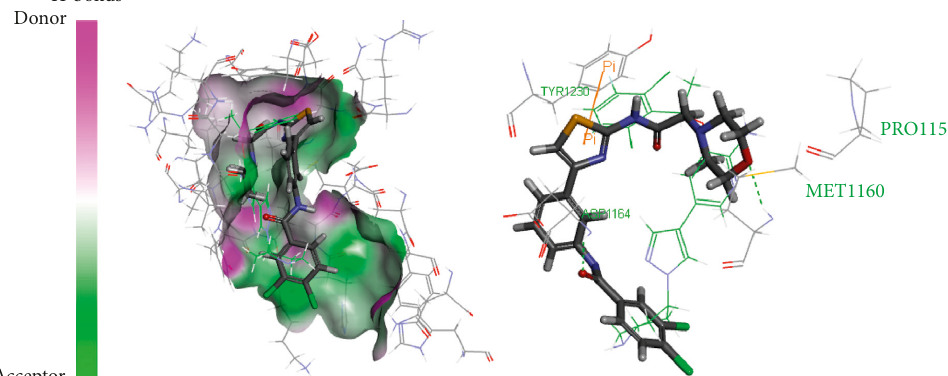
Figure 4: Binding mode of crizotinib (line) and compound 5b